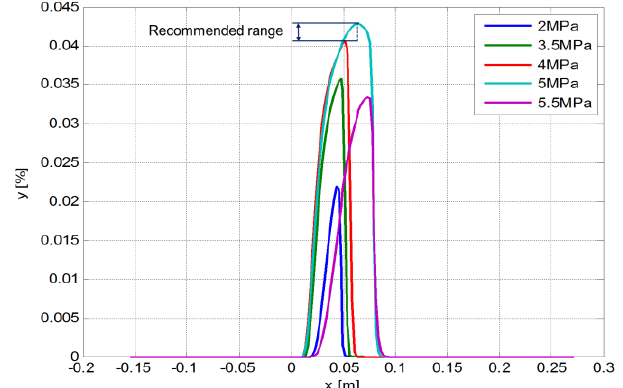
Figure 17. Humidity distribution curves along the axial cross-section of the supersonic separator at internal pressure values 2, 3.5, 4, 5, and 5.5 MPa.